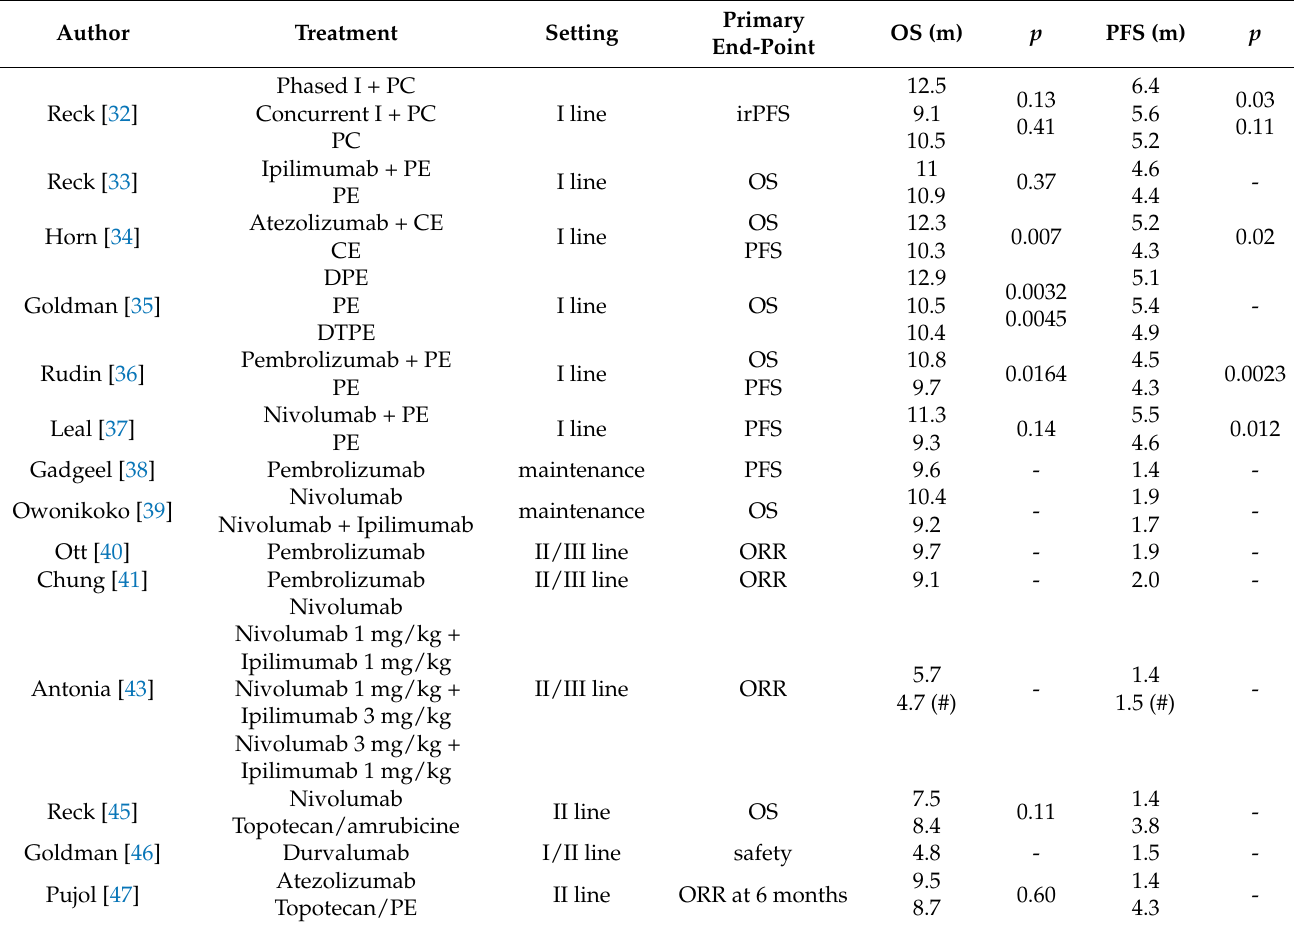
Table 2. Clinical trials exploring immune checkpoint inhibitors in patients with